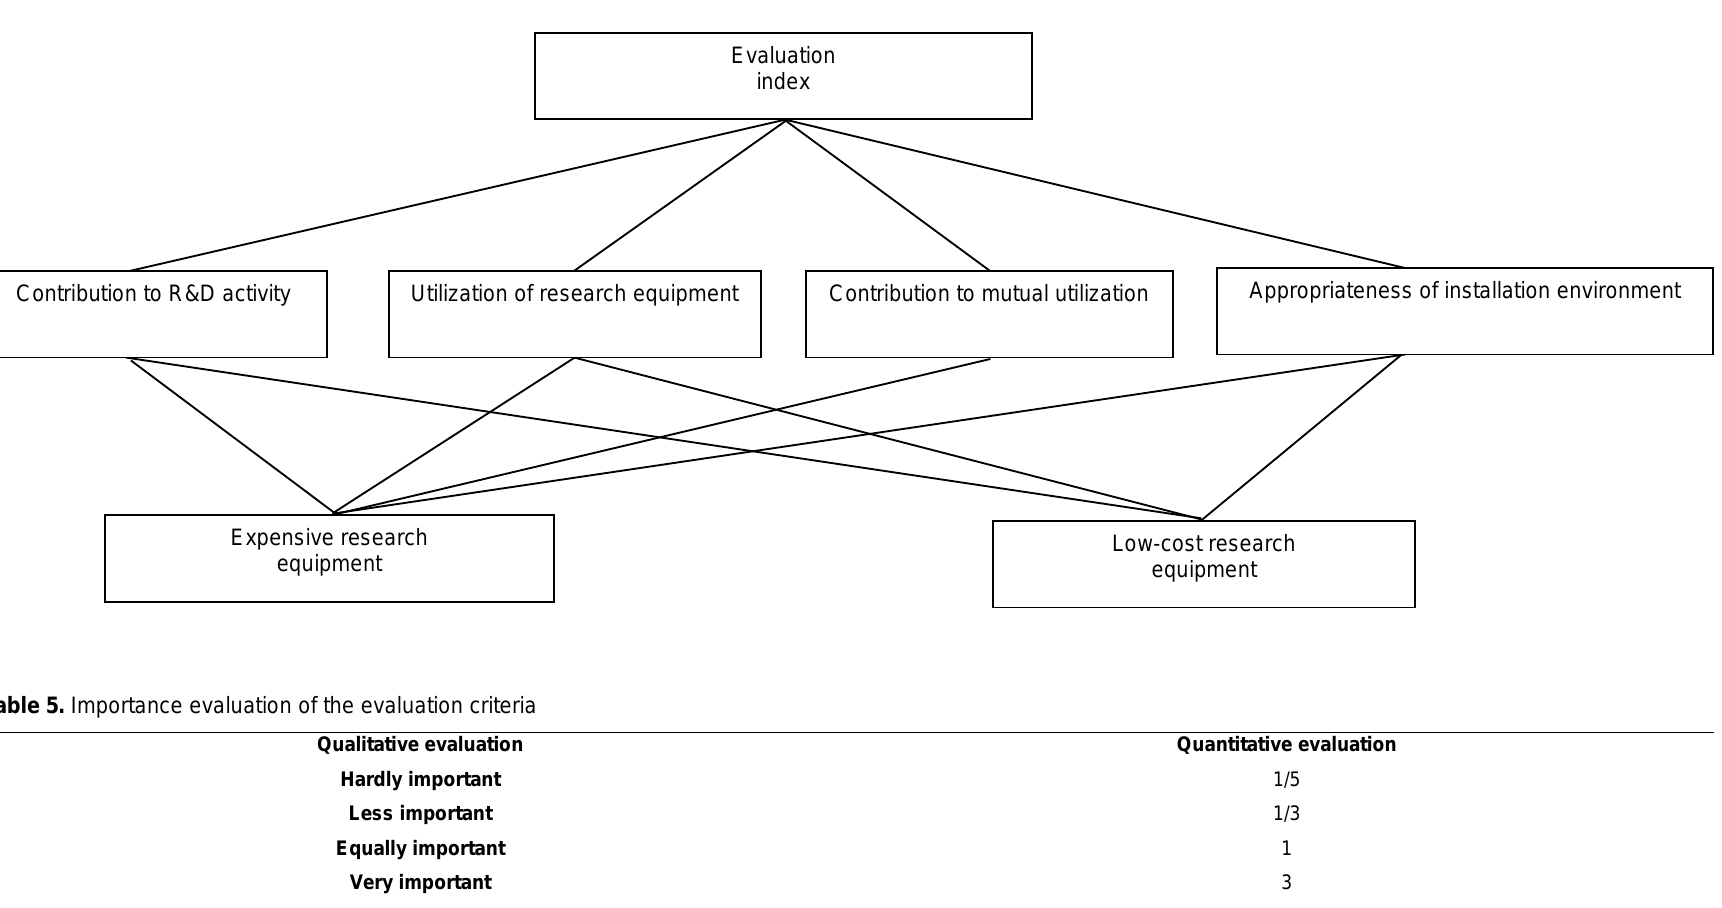
Figure 2. AHP model for evaluation index improvement for research equipment relocation